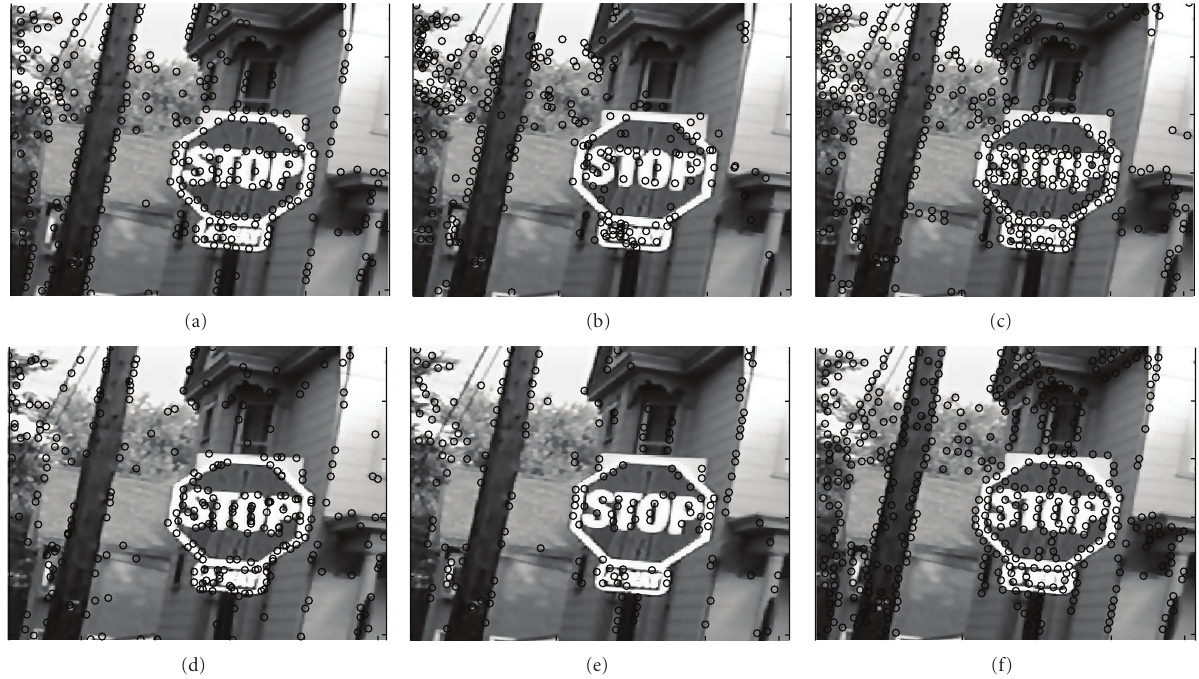
Figure 11: Feature points detected in the second image by (a) Harris’ method, (b) Lowe’s method, (c) Tomasi’s method, (d) Loupias’ technique, (e) Yeh’s algorithm, and (f) proposed